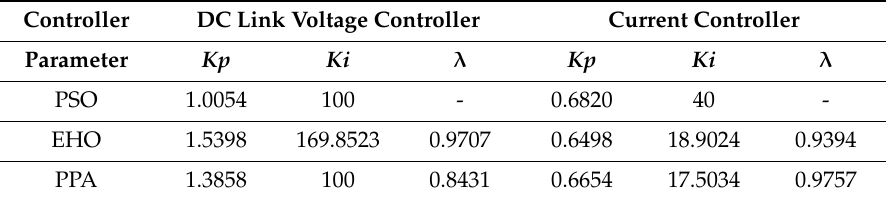
Table 4. Optimal value of gain parameters.